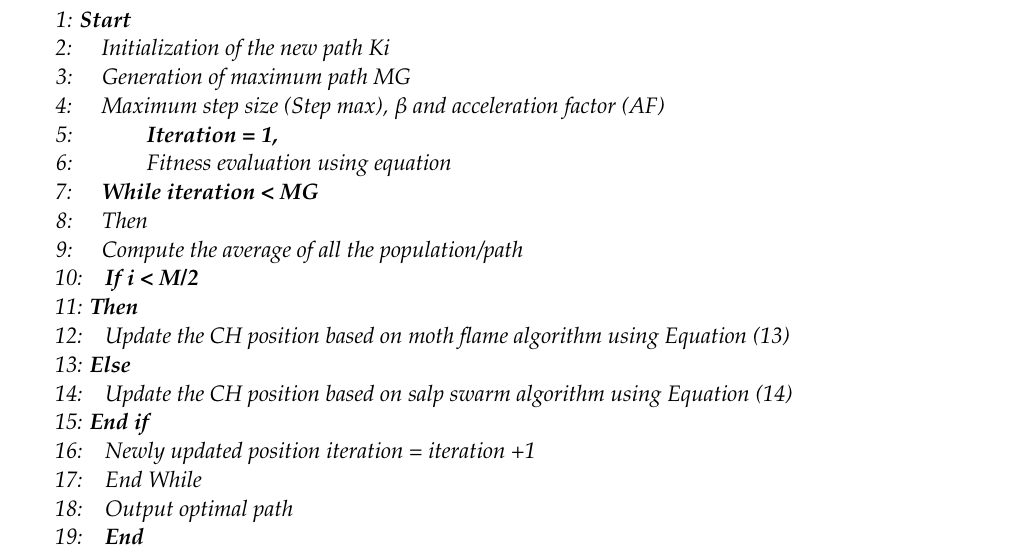
Algorithm 1. Pseudo code of the proposed Optimal Bio-inspired